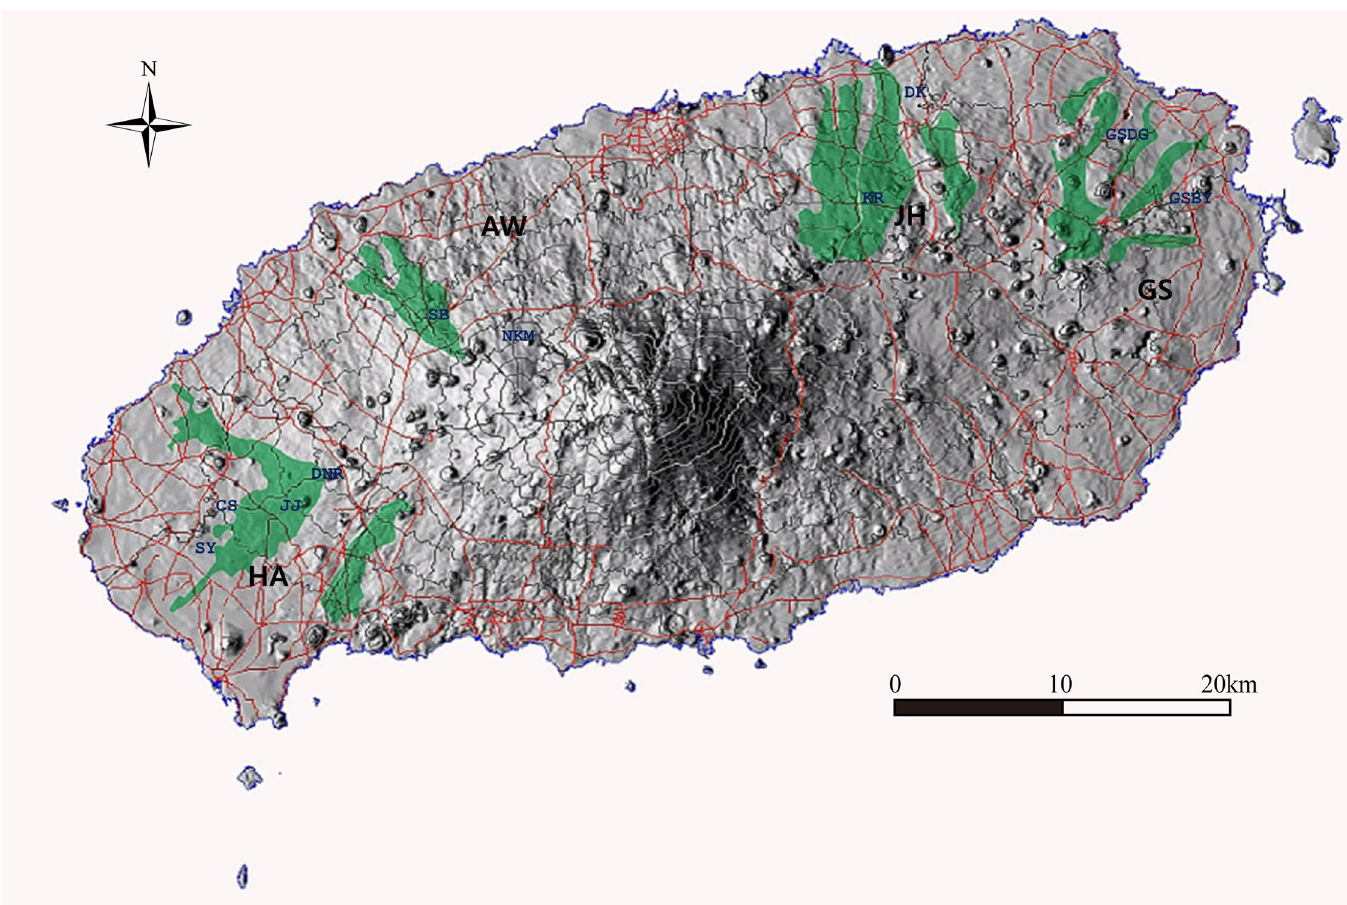
Fig 1. Map of Gotjawal forest sampling sites. The map is created using ArcGIS 10.3 (http://www.esri.com/arcgis/about.arcgis) and Surfer 8.0 software (http://www.